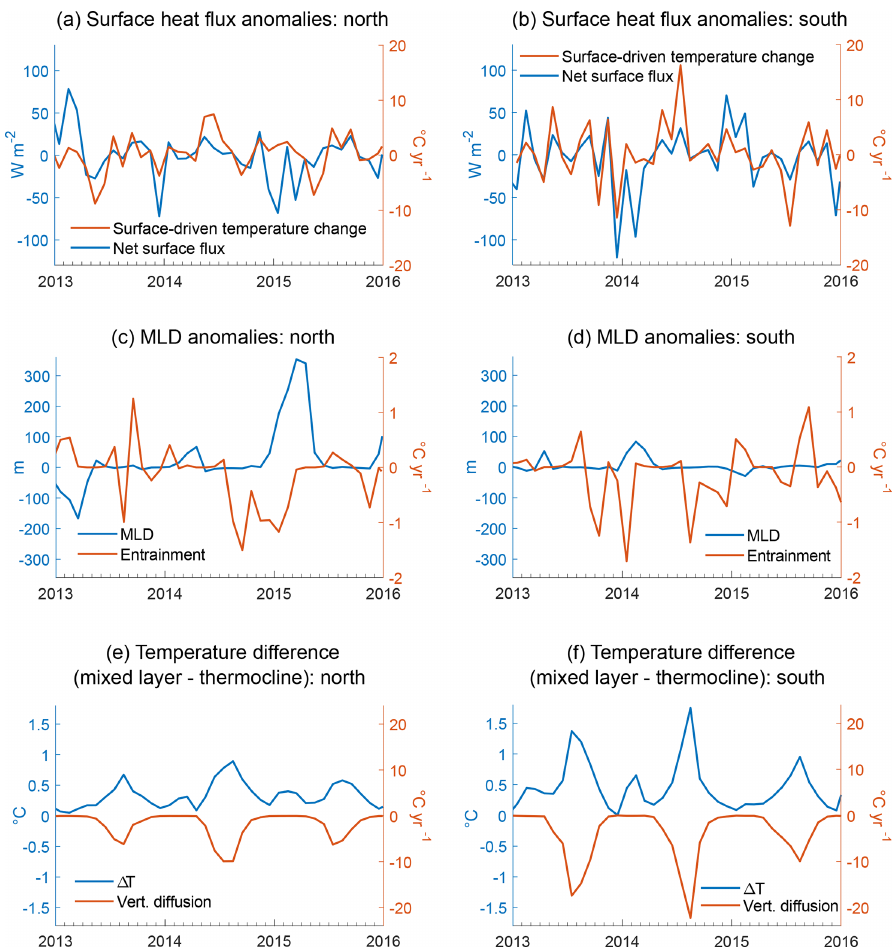
Figure 10. The individual components making up the dominant temperature budget terms and the associated change in mixed-layer temper- ature, as in Fig. 7 but averaged over the north (a, c, e) and south (b, d, f) of the cold blob region separately. Panels (a) – (d) show anomalies in the individual terms, while the seasonal cycle has not been removed for (e) – (f) . The time series of (a) – (d) prior to the removal of the seasonal cycle can be seen in Fig.